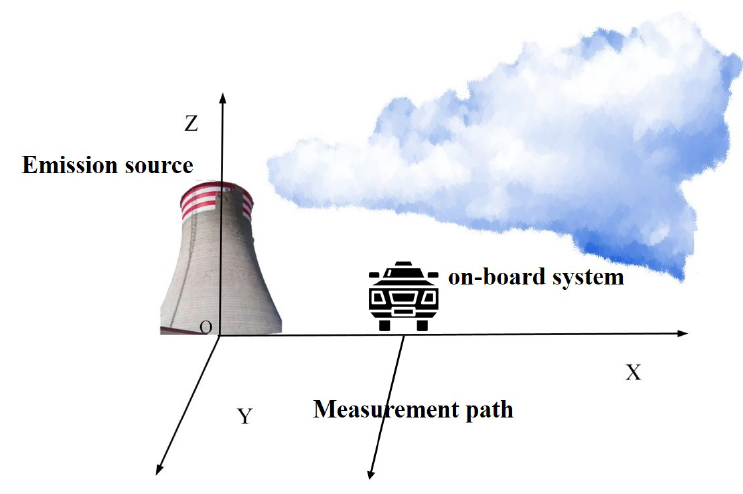
Figure 2. Mobile system measurement